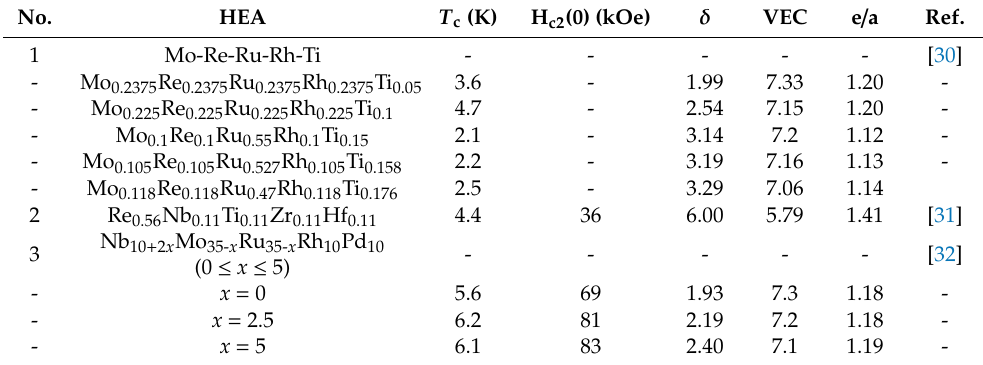
Table 3. Superconducting properties, δ , VEC and e / a of hexagonal-closed packing (hcp) and hcp-related HEA superconductors. T c and H c2 (0) data are from the references listed in the table. No. HEA T c (K) H c2 (0) (kOe) δ VEC e / a Ref. 1 Mo-Re-Ru-Rh-Ti - - - - - [30]